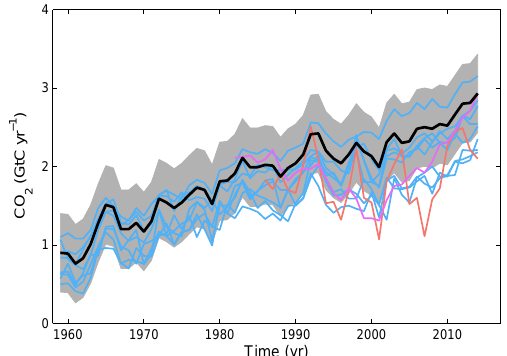
Figure 7. Comparison of the anthropogenic atmosphere–ocean CO 2 flux shows the budget values of S OCEAN (black), individ- ual ocean models before normalisation (blue), and the two ocean- data-based products (Rödenbeck et al., 2014, in salmon and Land- schützer et al., 2015, in purple; see Table 6). Both data-based prod- ucts were adjusted for the pre-industrial ocean source of CO 2 from river input to the ocean, which is not present in the models, by adding a sink of 0.45GtCyr − 1 (Jacobson et al., 2007) so as to make them comparable to S OCEAN . This adjustment does not take into account the anthropogenic contribution to river fluxes (see Sect.